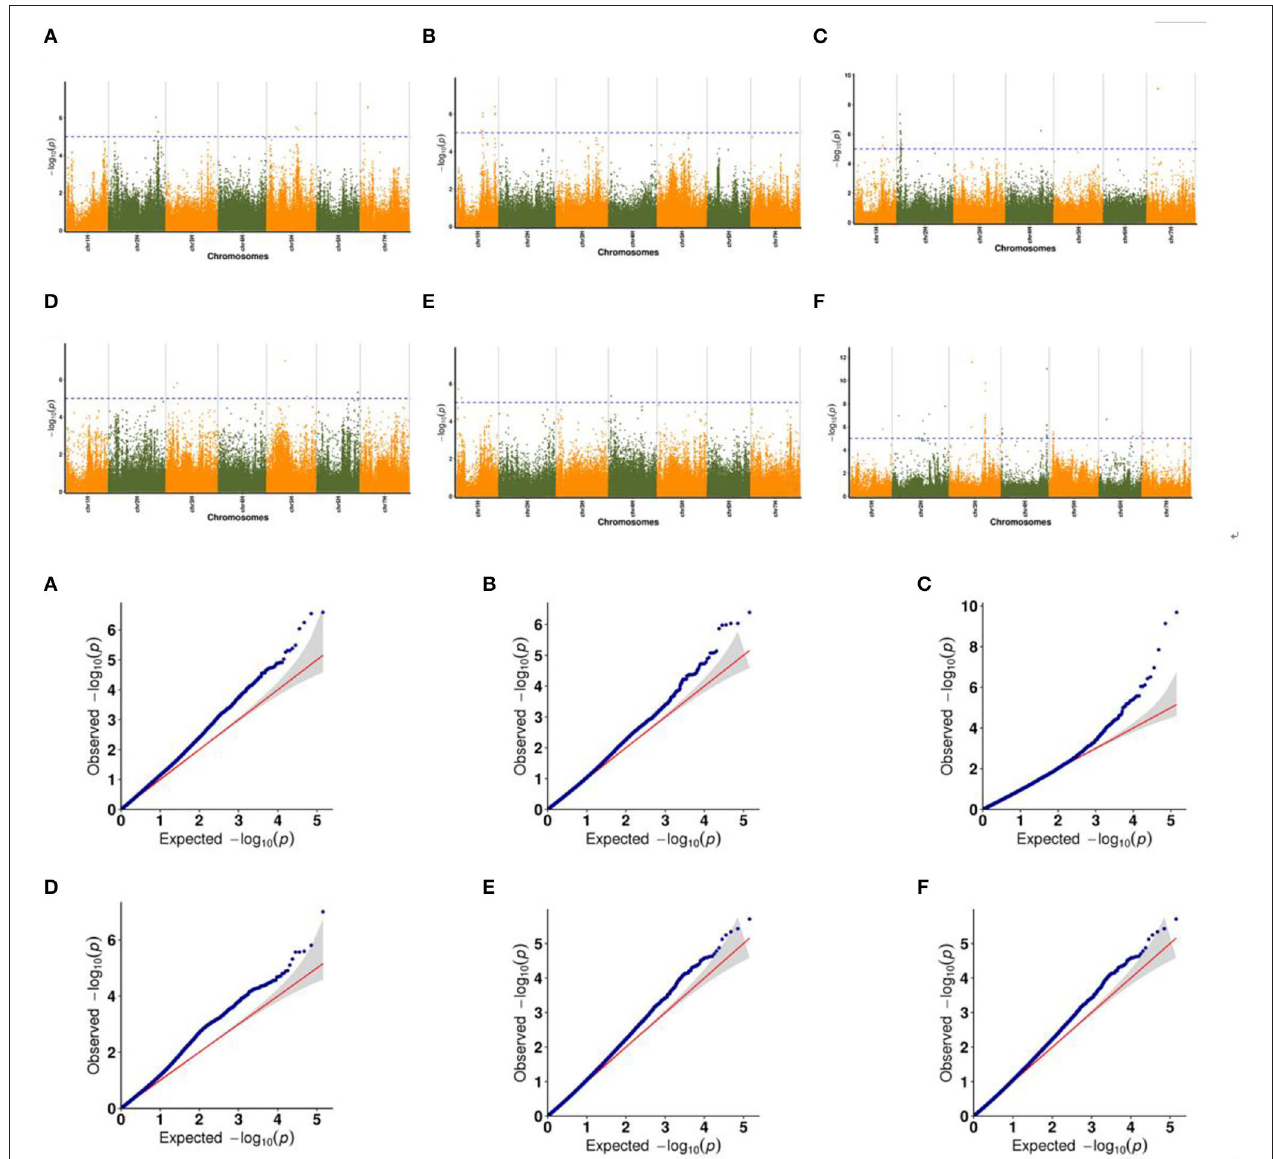
FIGURE 5 | Manhattan maps and Q–Q plots representing the SNP markers associated with drought resistant in multiple trials of GWAS associated with spike development. (A,B) ESNP, (C) MEN, (D) MSL, (E) RSWD, and (F) TGW.